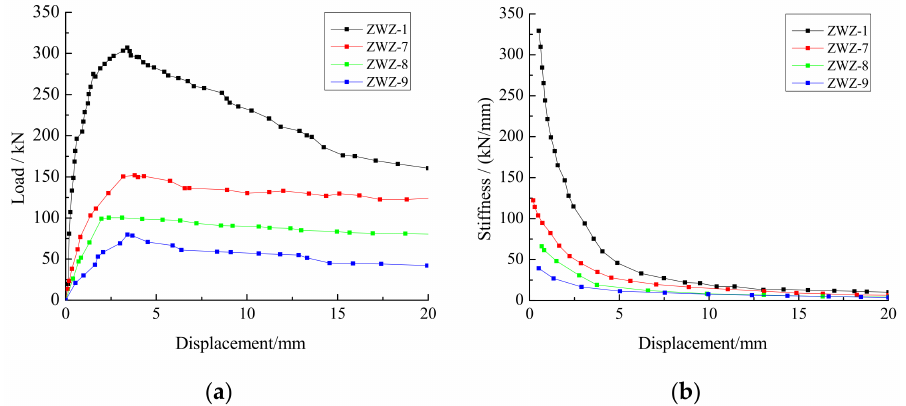
Figure 26. Load–displacement and stiffness–displacement curves with different door hole dimen- sions: ( a ) load–displacement curves; ( b ) stiffness–displacement curves.